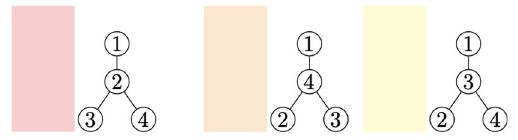
Fig. 3 The rectangles represent one T ( 1 , 1 )